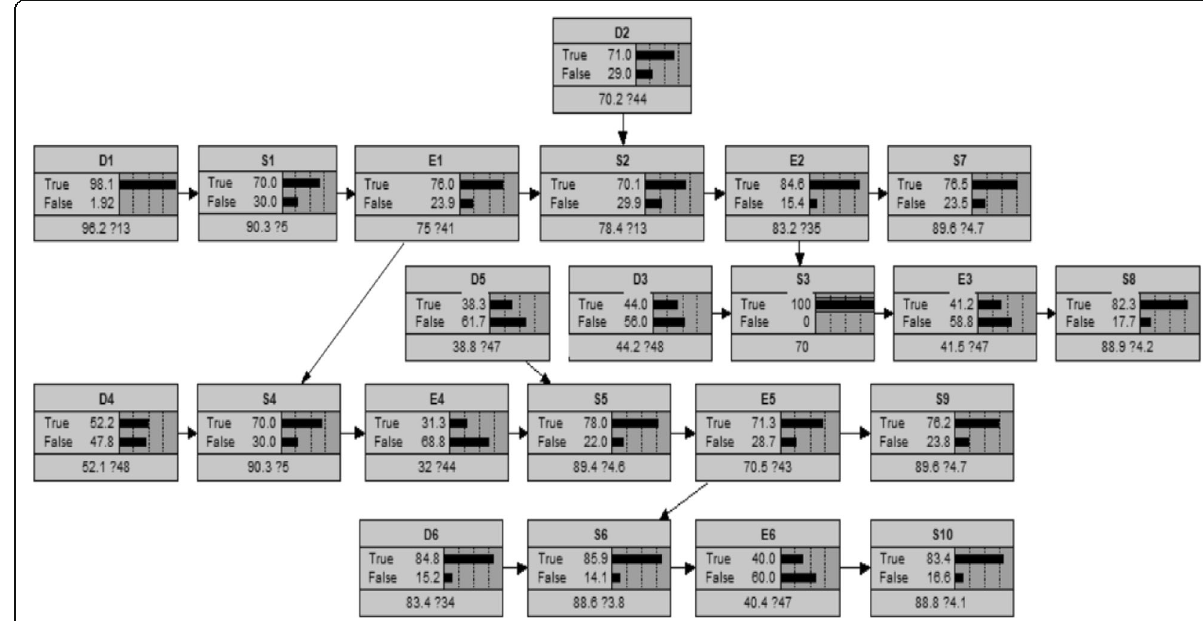
Fig. 7 Probability inference of the Gulf of Mexico oil leakage